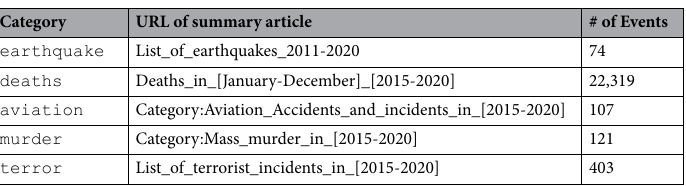
Table 1. Summary of Wikipedia page data. URL following: https:// en. wikip edia. org/